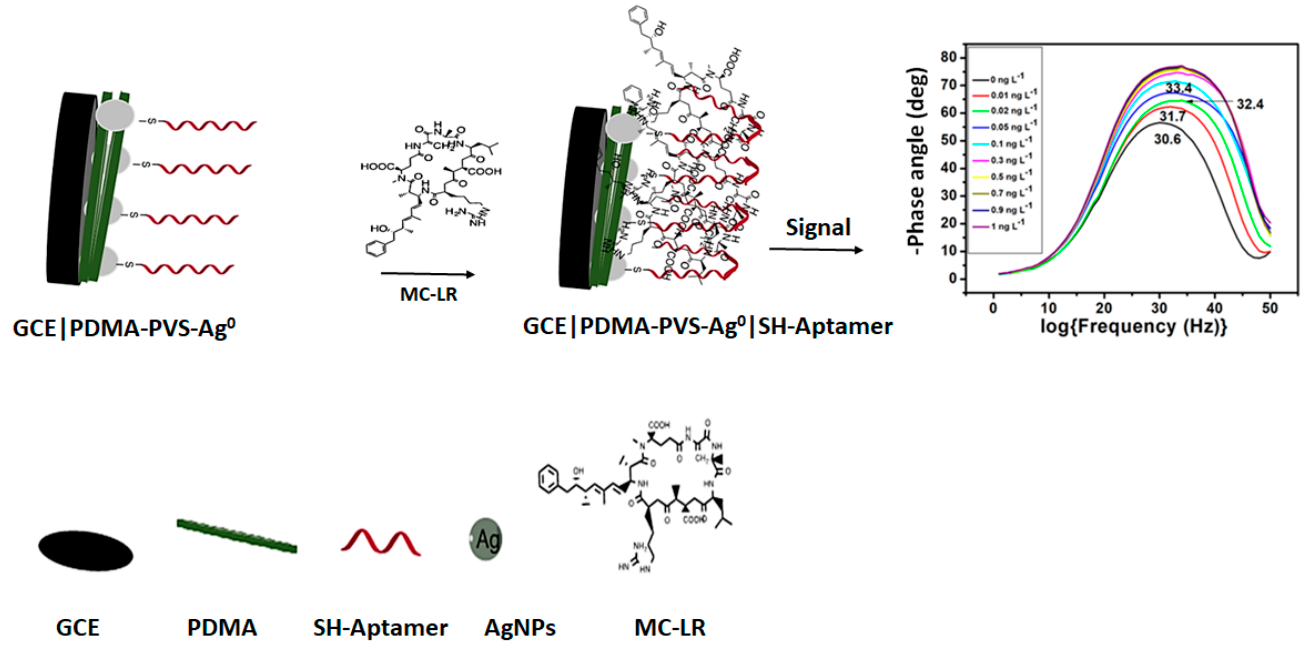
Scheme 1. Schematic representation of the aptasensor for MC-LR.